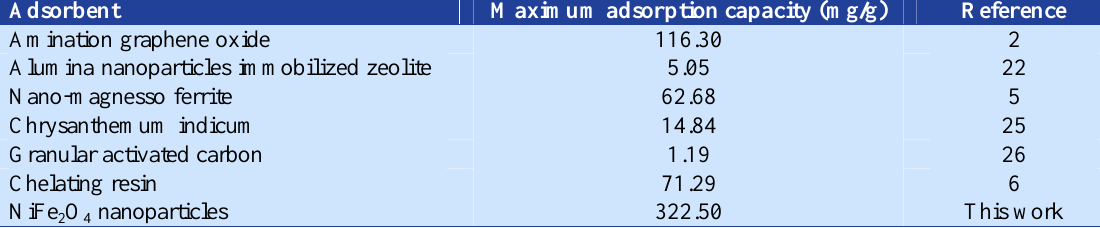
Table 2. Comparison of maximum adsorption capacity (q m ) of different adsorbents for Co(II) Adsorbent